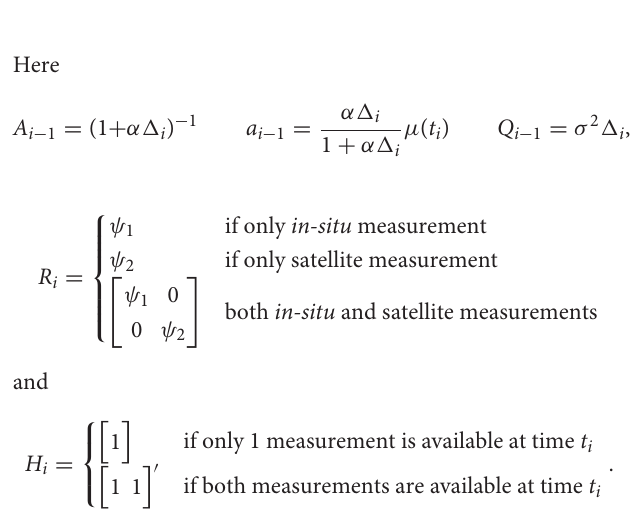
FIGURE 5 | Eight EURO-CORDEX (darker solid line) and 120 generated synthetic (shaded dashed line) climate change projections for solar radiation (A) and air temperature (B) , grouped by RCP scenarios (blue—RCP4.5, red—RCP8.5). Plot of the yearly averages based on the daily